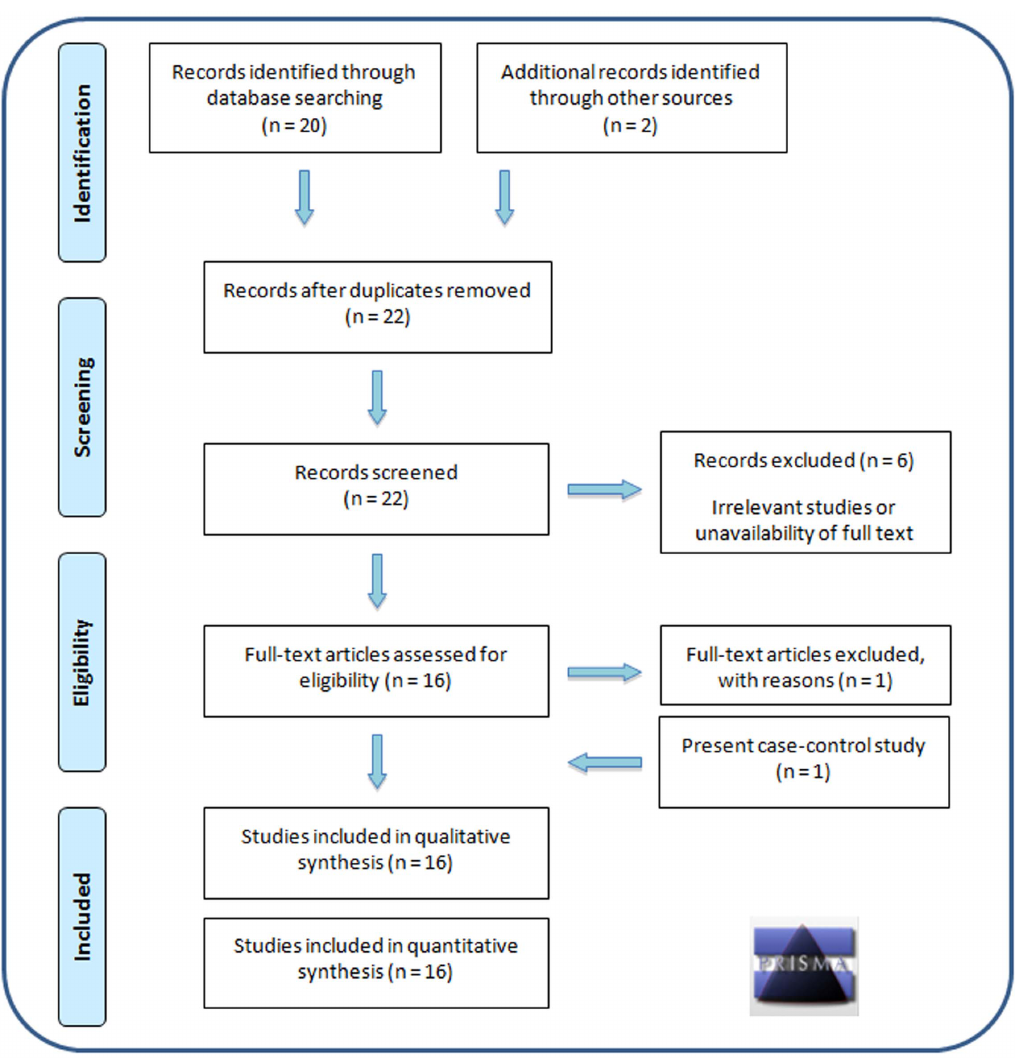
Figure 5. PRISMA flow diagram. A systematic flow diagram showing inclusion and exclusion of studies for meta-analysis.